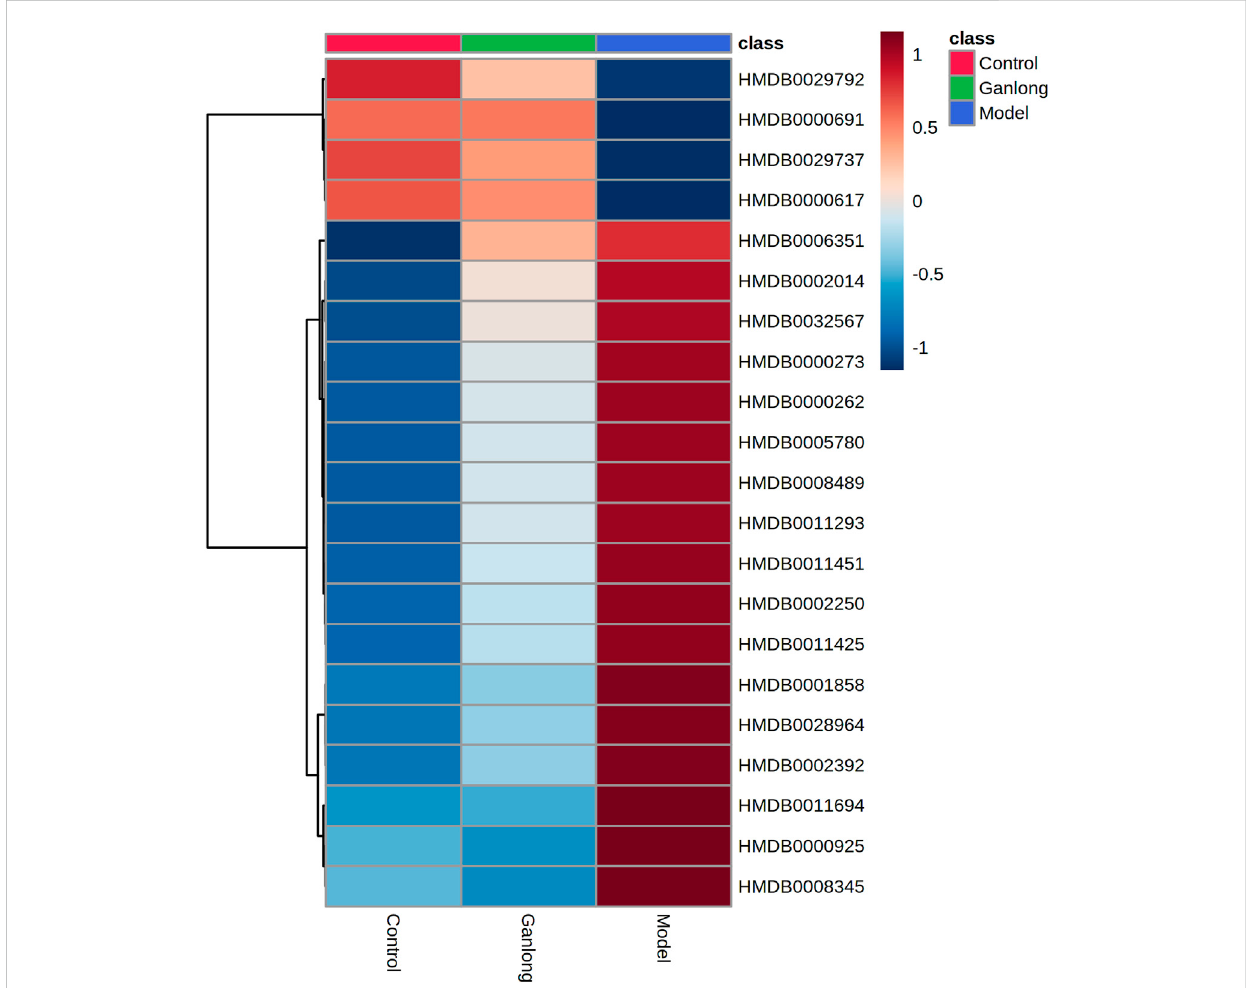
FIGURE 8 Heat map of potential biomarker expression in serum of rats in each group. Control group, model group and Ganlong capsule treatment group ( n =6). Model group compared with normal control group, * p < 0.05, ** p < 0.01. Ganlong capsule group compared with model group, # p < 0.05, ## p <